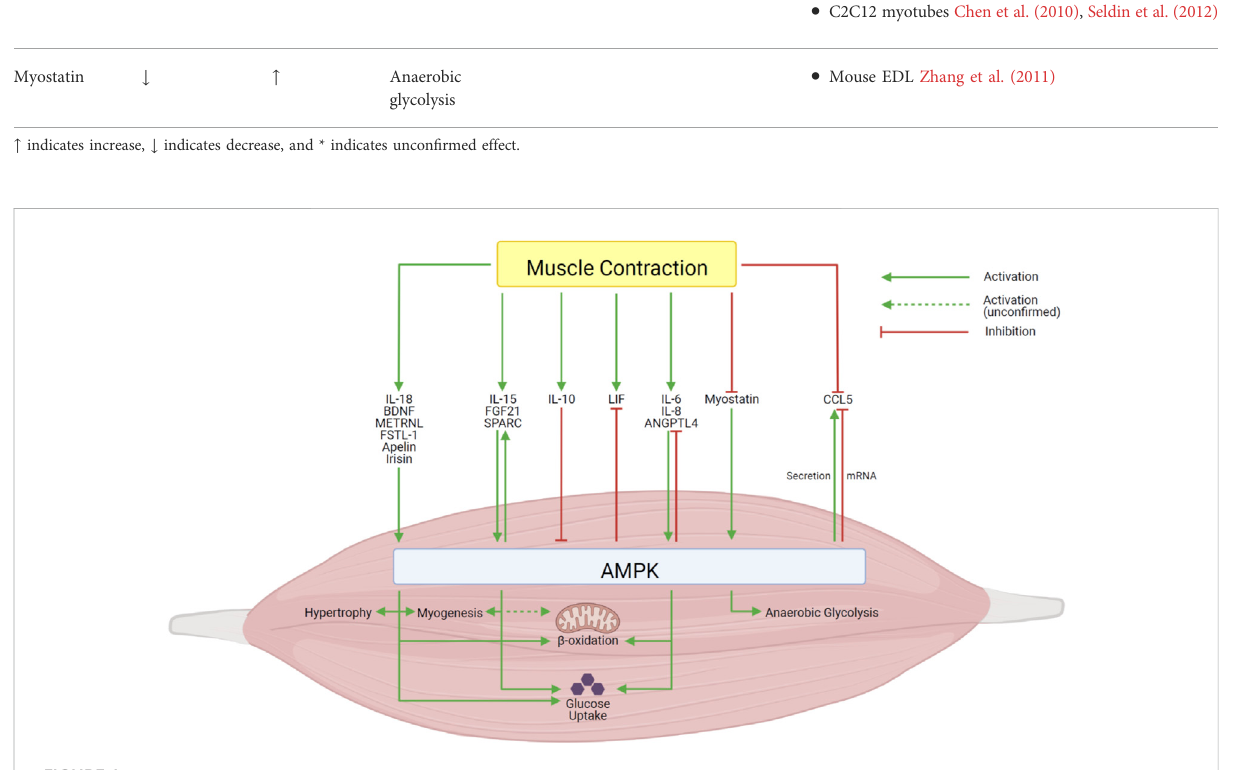
FIGURE 1 Summary of the effects of the interactions between myokines and AMPK in skeletal muscle. Created with BioRender.com.